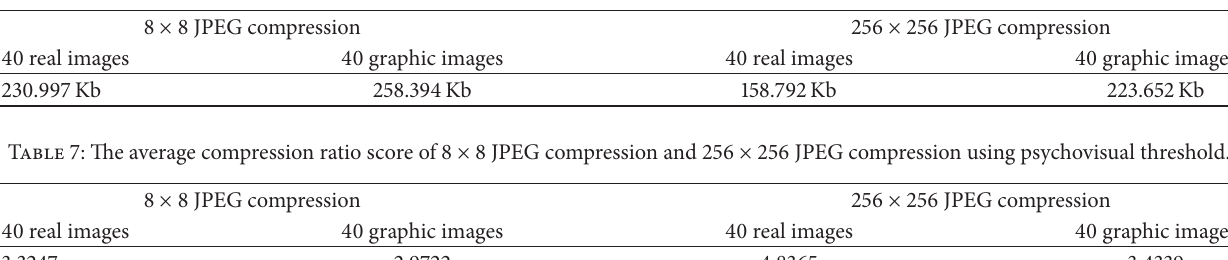
Table 6: The average bit size of 8 × 8 JPEG compression and 256 × 256 JPEG compression using psychovisual threshold.